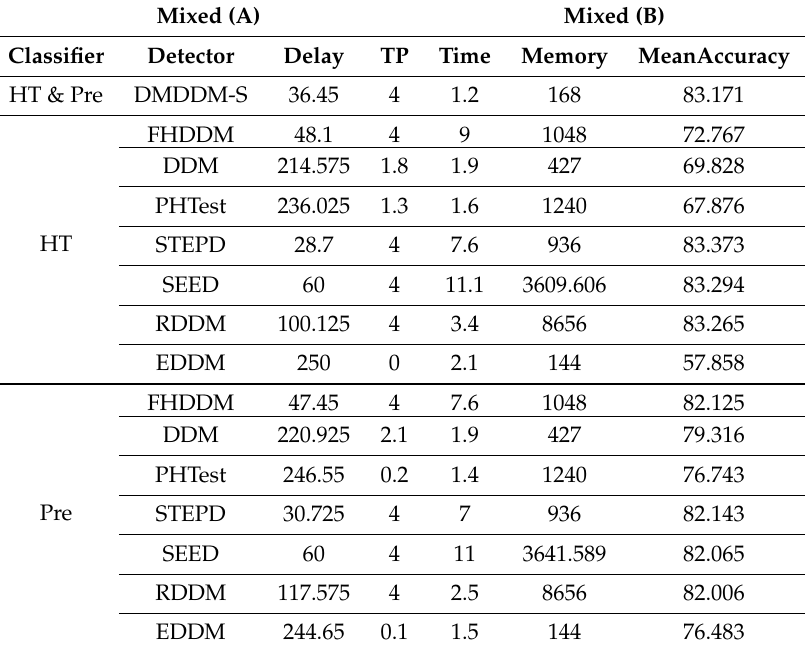
Table 4. Results of Mixed dataset with (10%